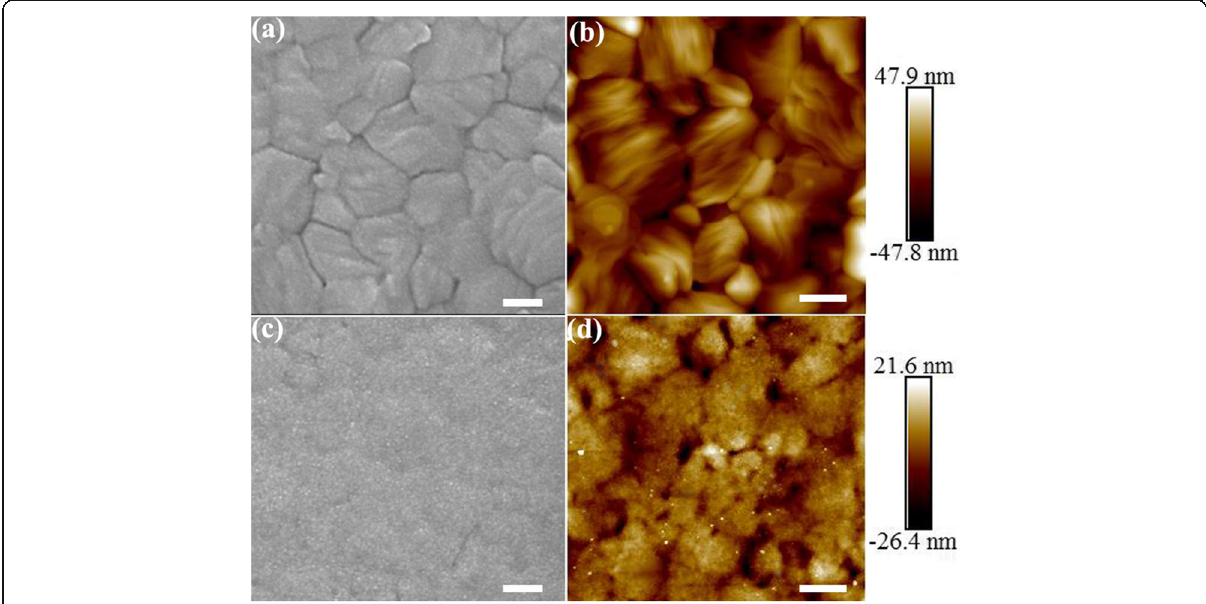
Fig. 1 SEM and AFM topology of bare perovskite film ( a , b ) and CdSe/LiF-covered perovskite film ( c , d